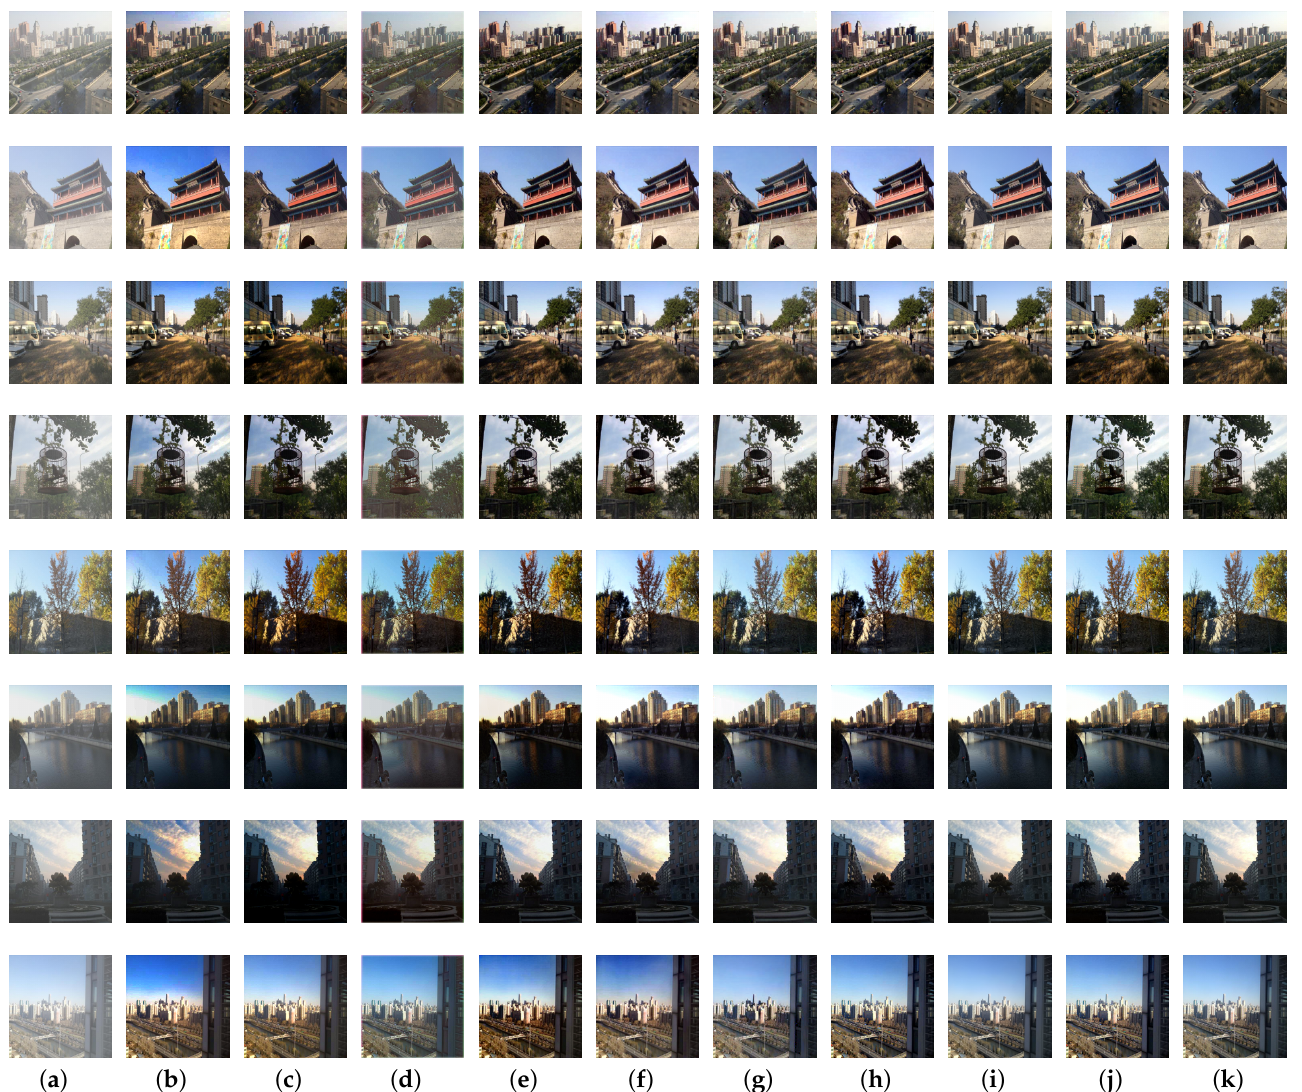
Figure 10. Visual results on synthetic images of RESIDE dataset: ( a ) hazy images; ( b ) DCP; ( c ) CAP; ( d ) AODNet; ( e ) EPDN;